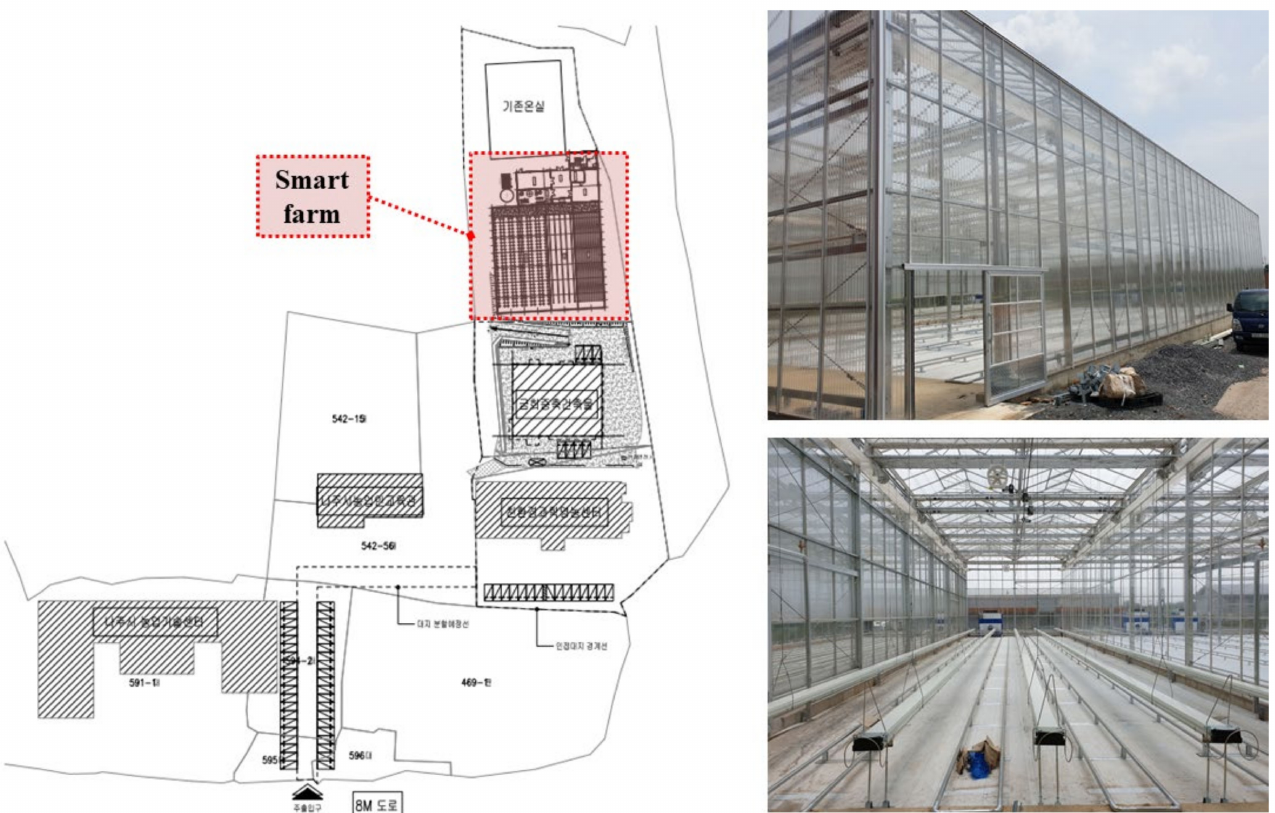
Figure 8. Target Greenhouse